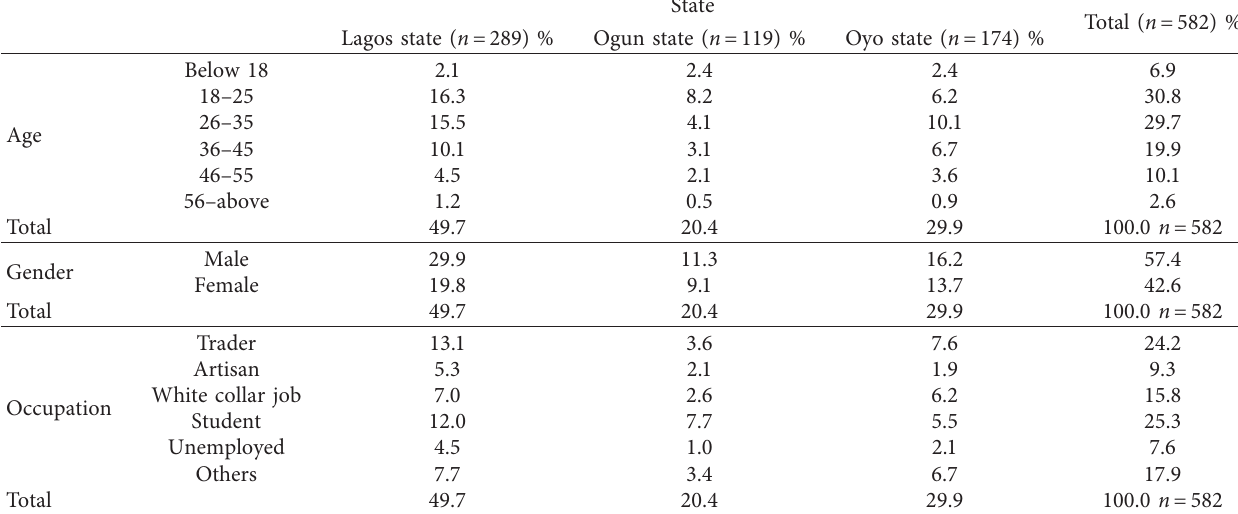
Table 1: Demographic characteristics of participants.